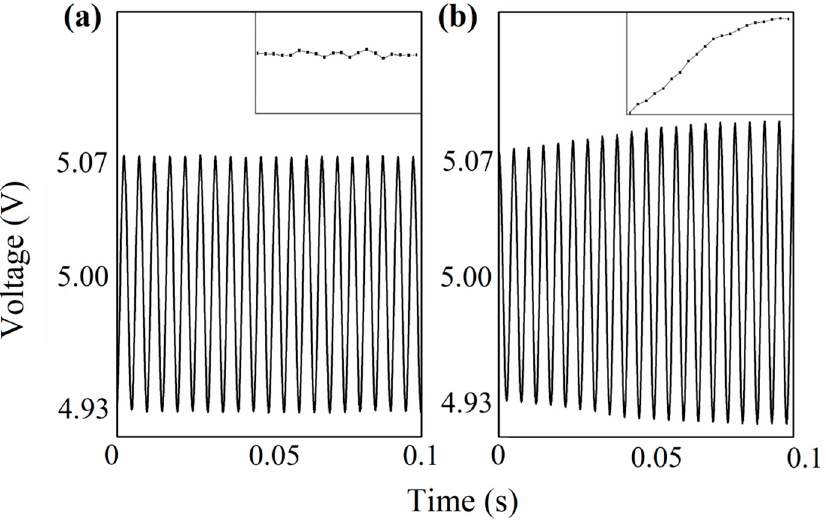
Figure 4. Original measured signal shown on the oscilloscope and its amplitude (inset). ( a ) The stable amplitude indicates stable amplitude of the force acting on the PM; ( b ) The amplitude is increasing, indicating the amplitude of the force is disturbed.